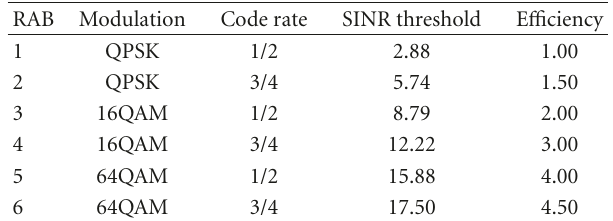
Table 4: RABs (Modulation and coding